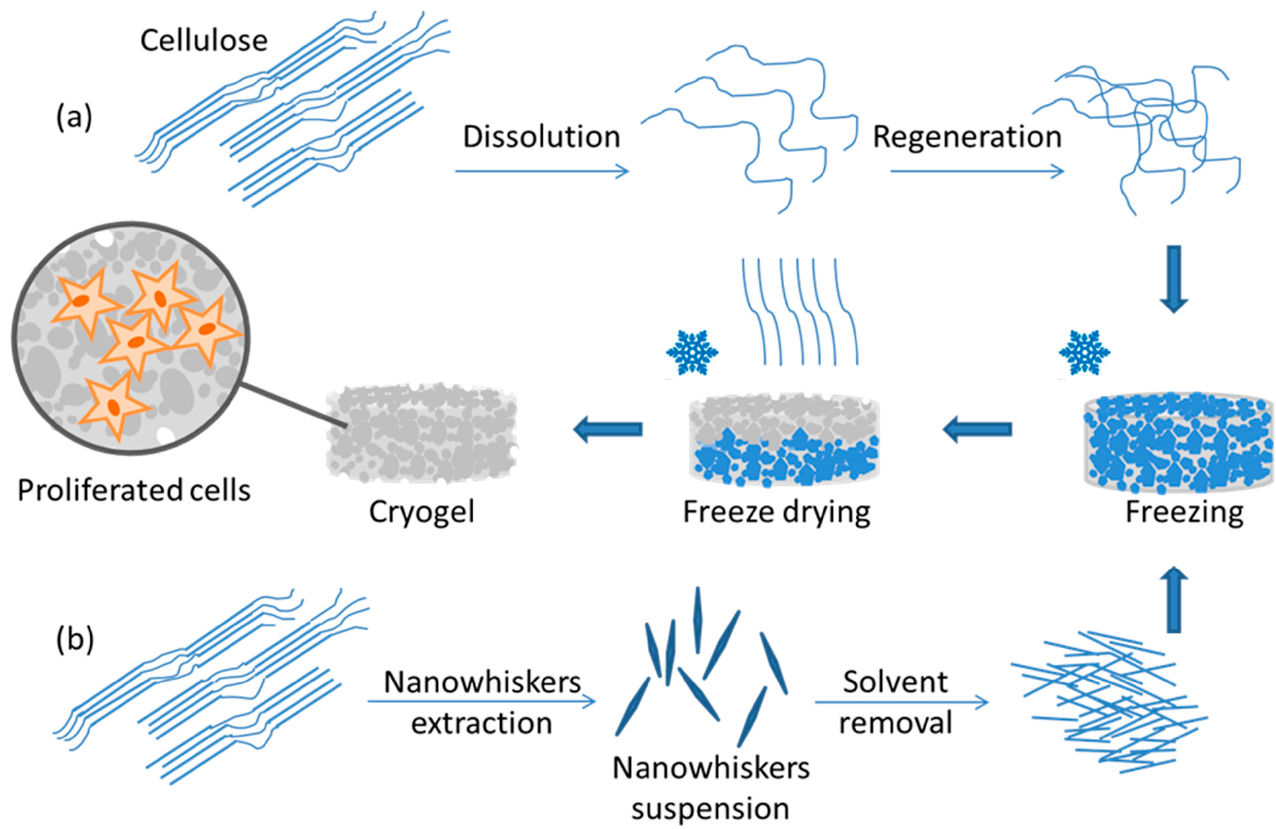
Figure 1. Ways to produce cellulose cryogel for biomedical applications: ( a ) via dissolution and regeneration; ( b ) using nanowhiskers.